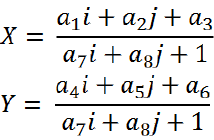
Figure 4: Blooming effect of car lights.